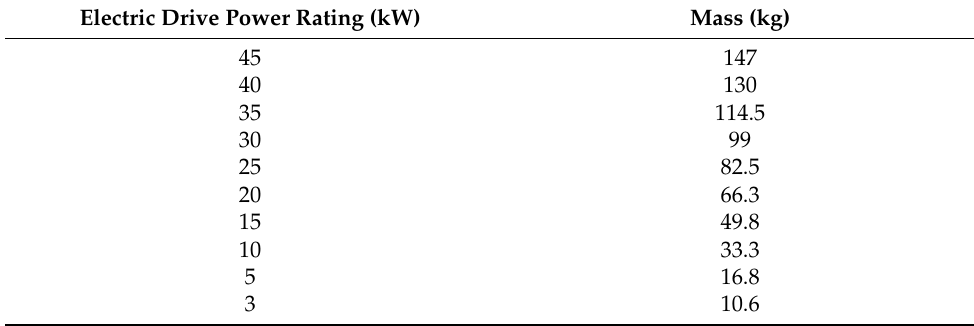
Table 3. Mass estimation of the electric drives. Adapted from Ref.